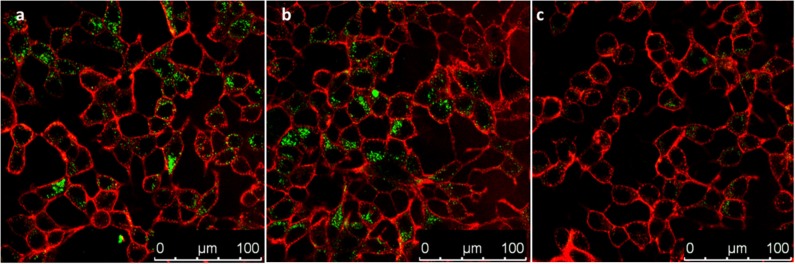
Confocal microscopy images of MCF-7 cells incubated for 24 h in the presence of PS3 at different concentrations in incubation medium: (a) 100 μg/mL; (b) 50 μg/mL; (c) 25 μg/mL. Images show PS3 emission in green and plasma membrane labeled with WGA-Alexa Fluor 633 in red.